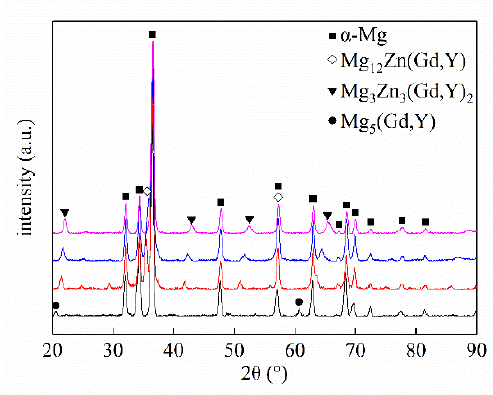
Figure 3. XRD results of Mg–7Gd–5Y– x Zn–0.5Zr alloys.